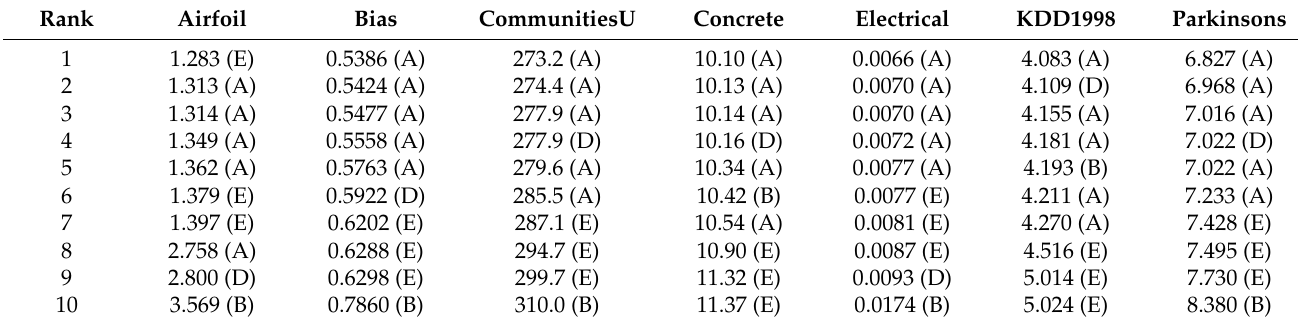
Table 5. Top 10 machine learning models excluding neural network models.